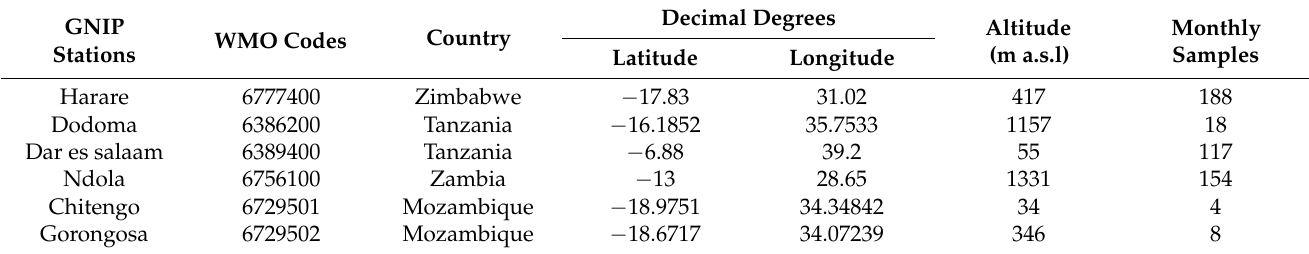
Table 2. Summary of isotopic sampling undertaken from Global Network of Isotopes in Precipitation (GNIP) Stations